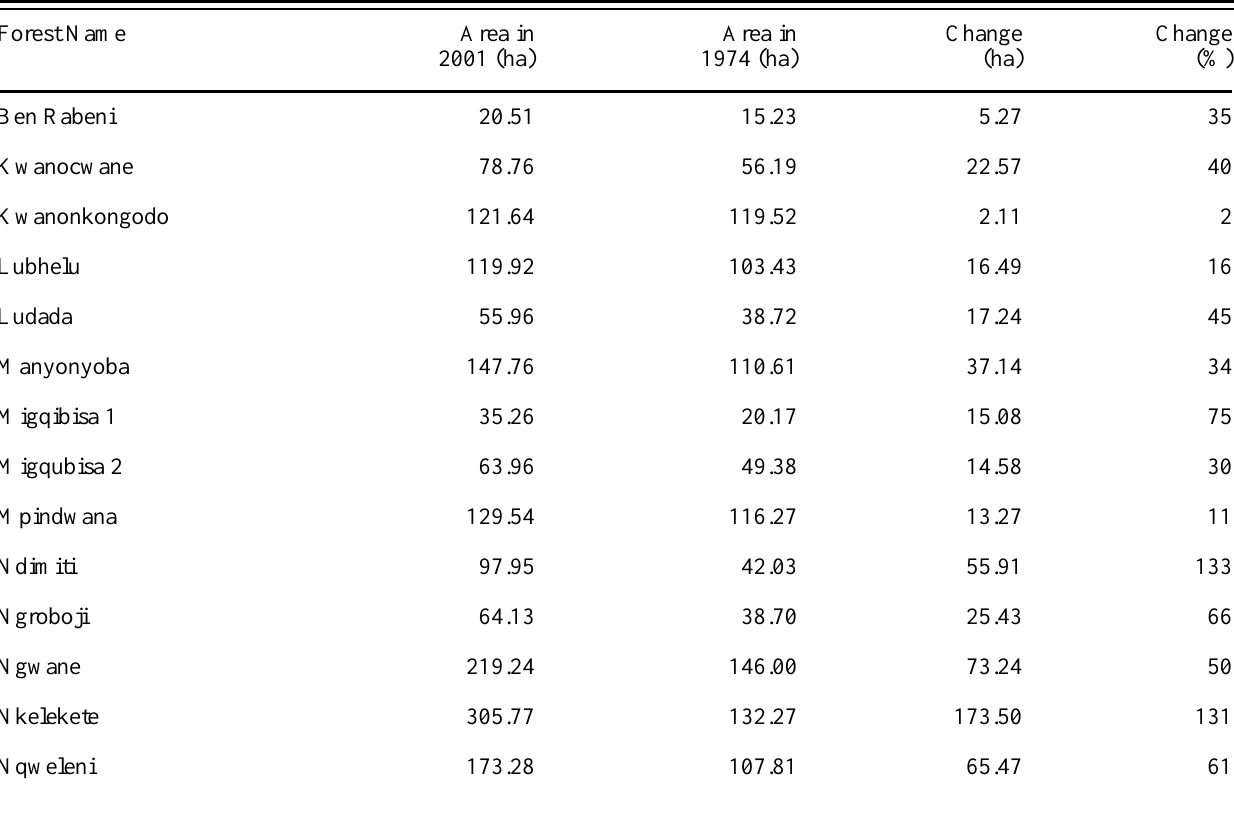
Table 1. Changes in forest and woodland cover in 14 forest patches between 1974 and 2001, as measured from orthorectified aerial photos. All forest patches are indigenous scarp forest (Reyers and Ginsburg 2005), and none have formal protection. The community has, however, submitted proposals and management plans to government for a Nqabara Community Conservancy, which will include all